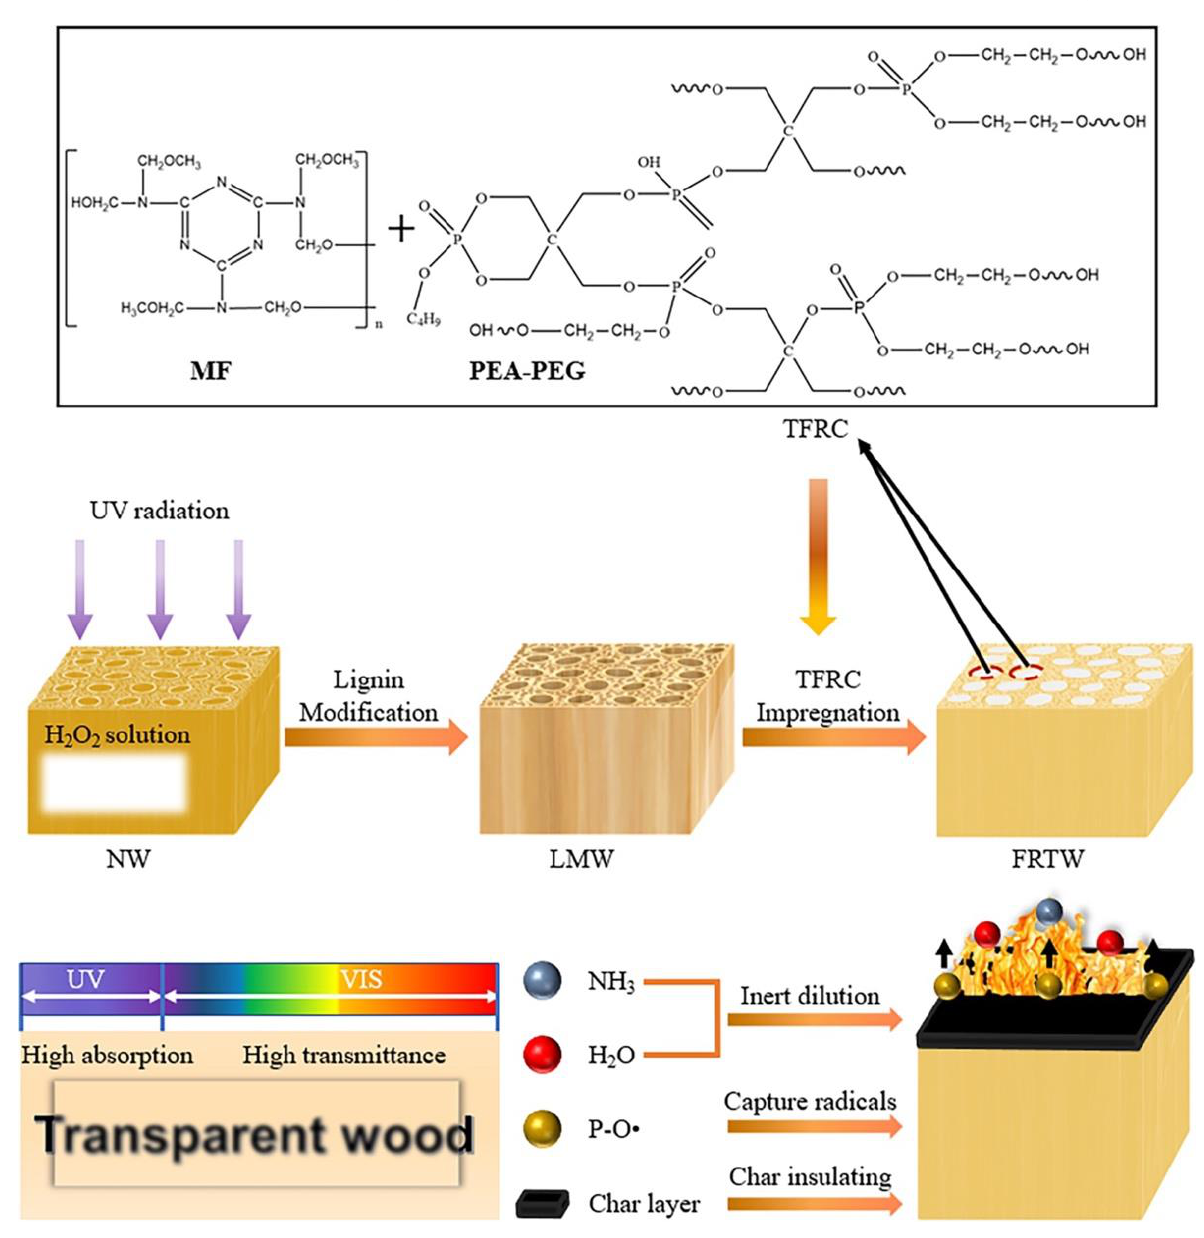
Figure 34. Schematic illustration of the preparation of flame-retardant transparent wood (FRTW), together with the demonstration of its optical and flame-retardant properties. NW = natural (pris- tine) wood; LMW = lignin-modified wood; MF = melamine–formaldehyde resin; PEA-PEG = flame- retardant product obtained by reacting poly(ethylene glycol) with cyclic phosphate ester; TFRC = transparent flame-retardant resin system. Reprinted with permission from [49], copyright 2022, John Wiley & Sons.